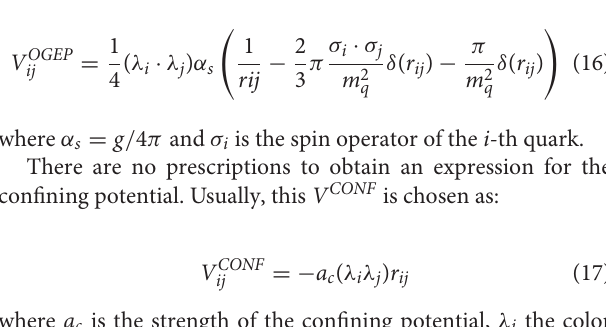
FIGURE 1 | Singlet S and triplet S phase shifts as a function of the two-nucleon center of mas energy for the NN channel. The parameters of the quark-quark interaction are given in the text.